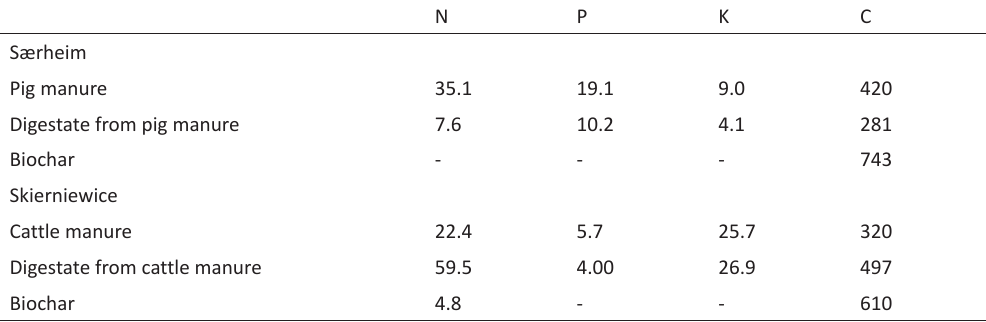
Table 4. Nutrient and organic carbon (Corg) content (g kg -1 DM) of the organic amendments used in field experiments N P